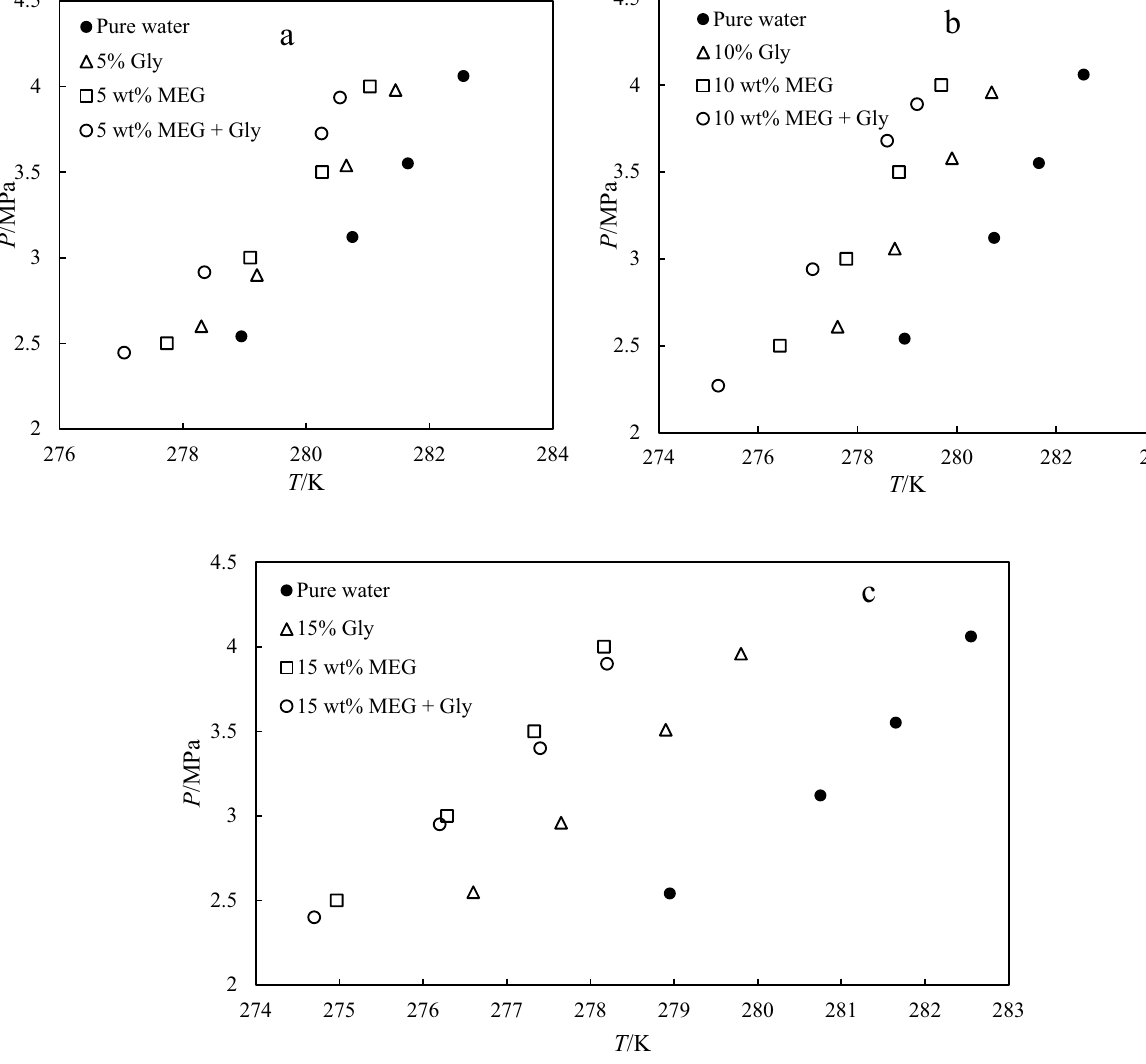
Figure 2. HLVE curve of CO 2 hydrate for pure water and ( a ) 5wt.% of THIs ( b ) 10 wt.% of THIs, and ( c ) 15 wt.% of